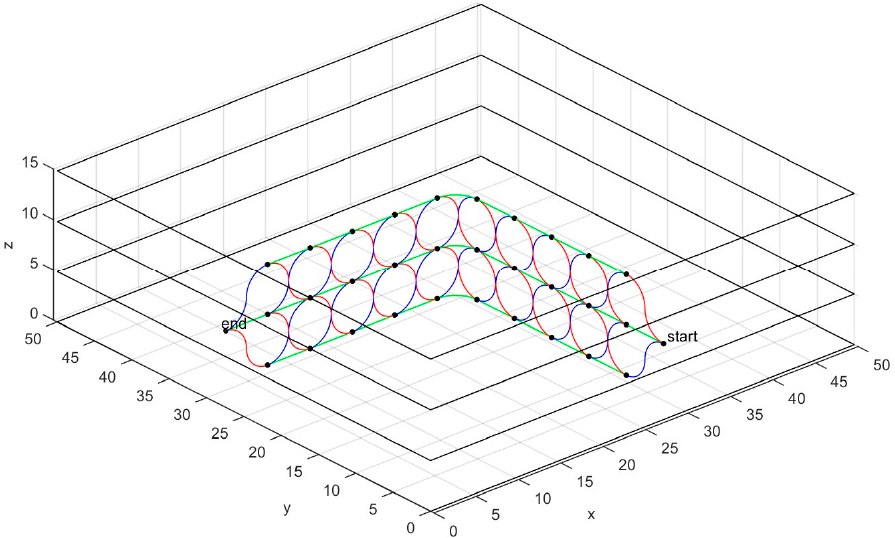
Figure 5. 3D view of graph to be searched for a UAV entering from the left-most entrance lane.